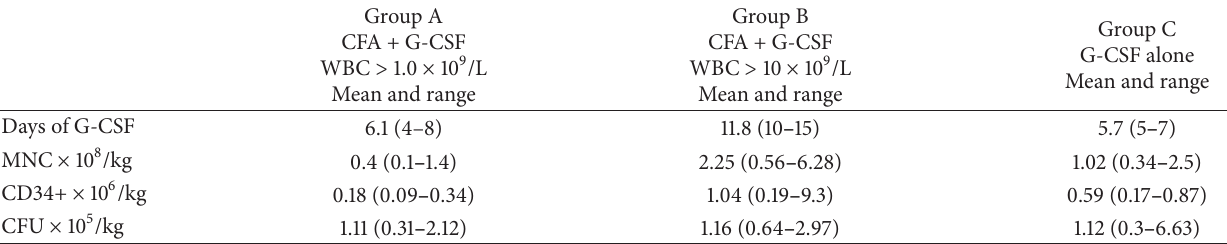
Table 2: PBPC results by group.